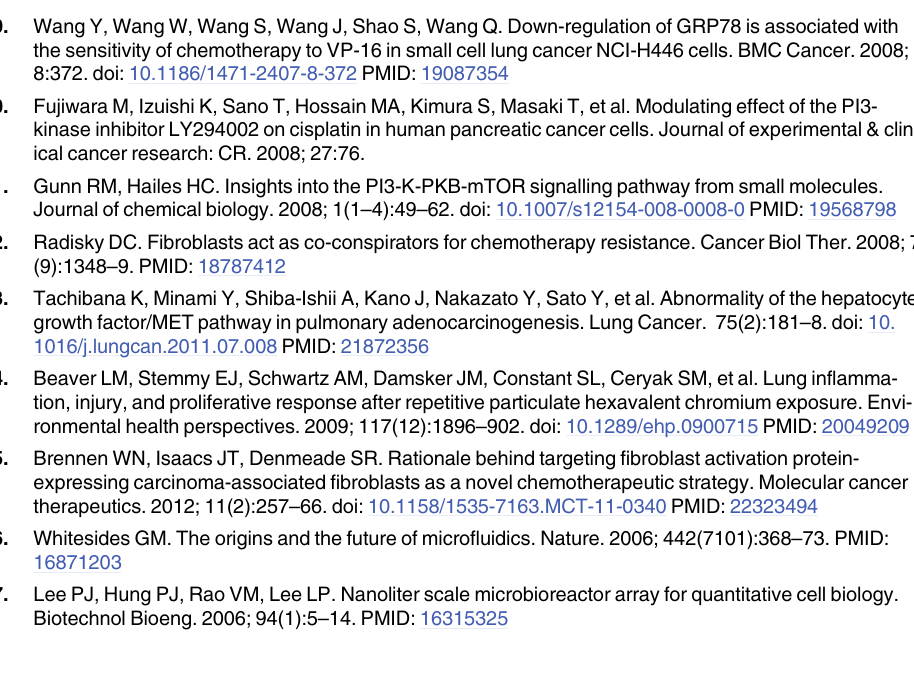
PLOS ONE | DOI:10.1371/journal.pone.0129593 June 26, 2015 15 /